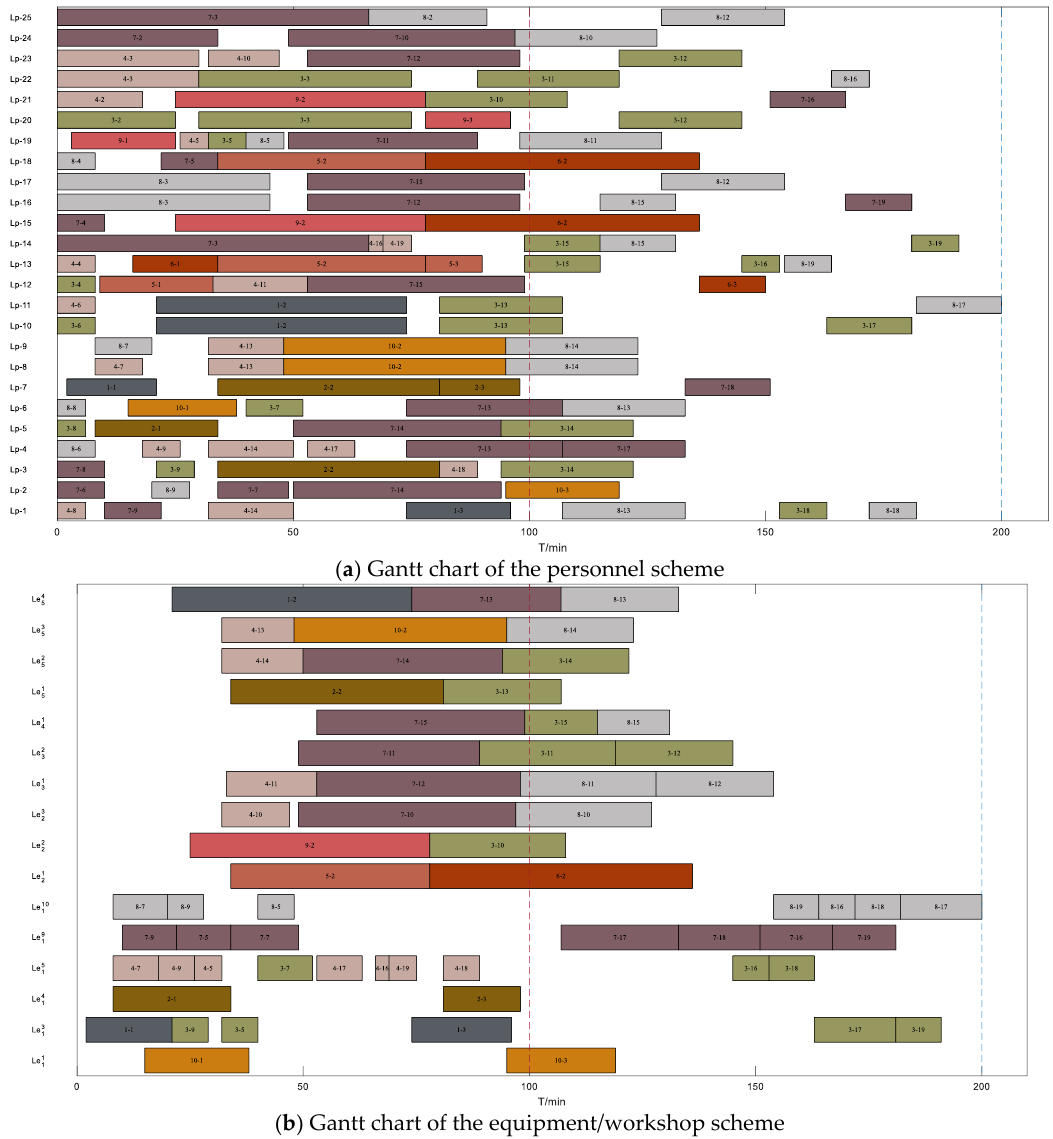
Figure 14. Gantt chart of maintenance and repair (MR) task scheduling schemes.